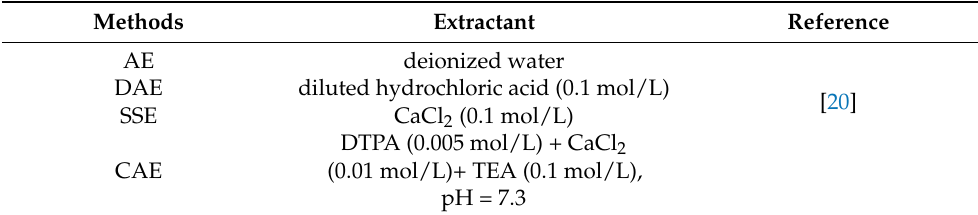
Table 1. Single extractions used in this study.